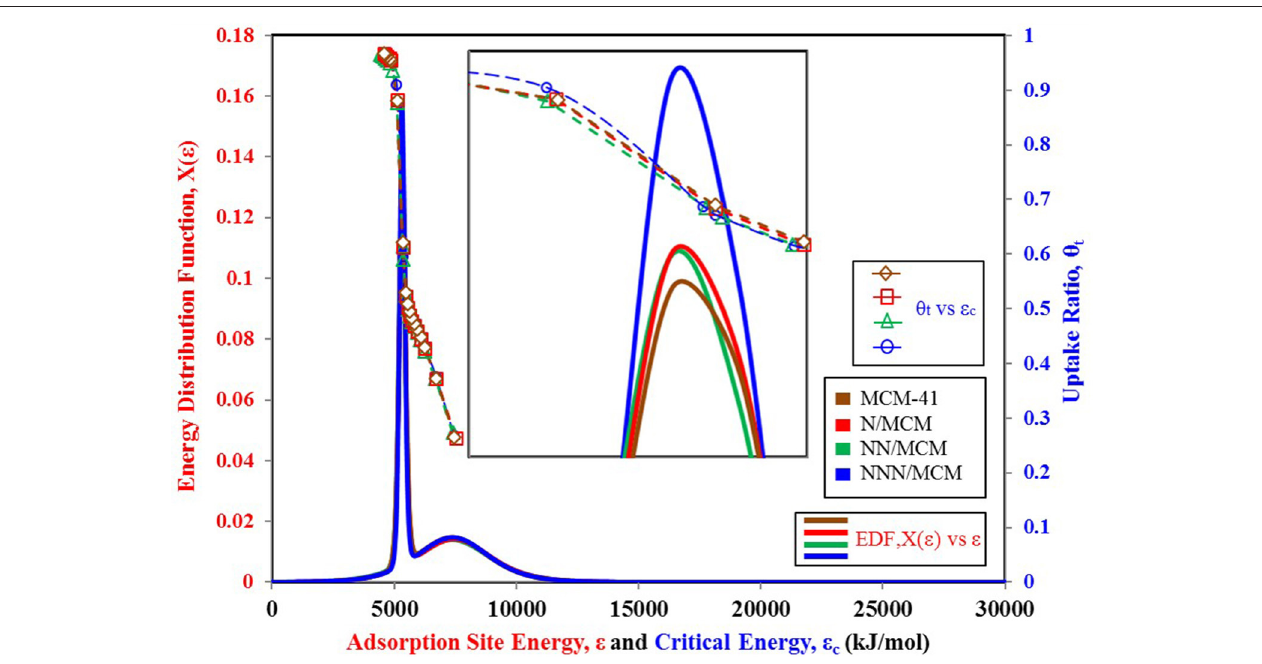
FIGURE 6 | Adsorption sites energy distribution for MCM-41 variants paired with nitrogen as adsorbate.